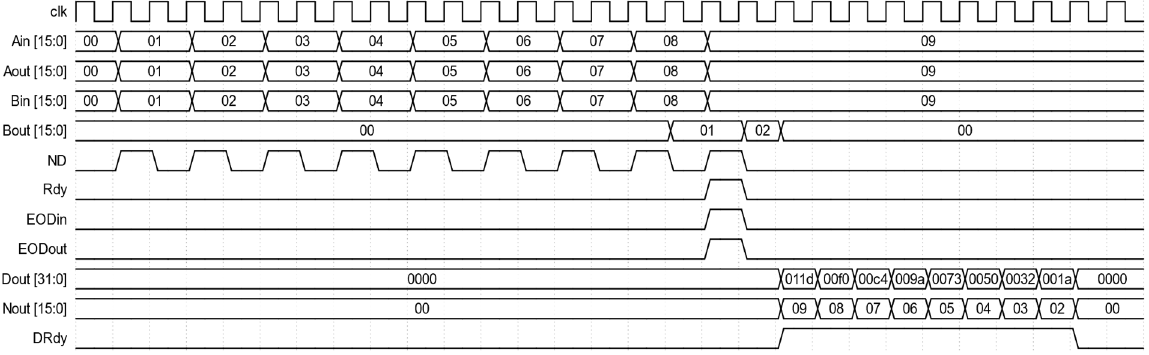
Figure 4. Waveforms of inputs and outputs for the 8-LC module. All values shown are in hexadecimal and are valid when their corresponding validation signals are active high.